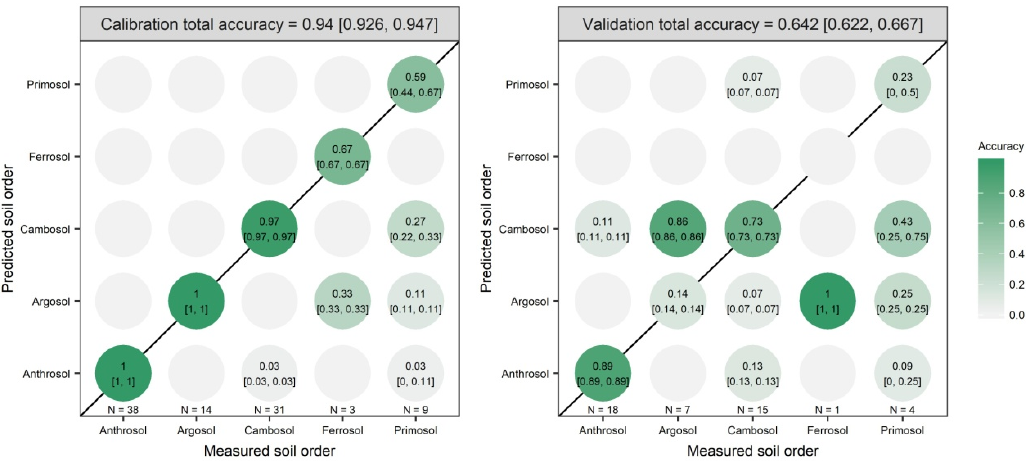
Figure 5. Confusion matrix of soil classification based on vis–NIR spectra. Inside the square brackets are lower and upper limits of the 90% confidence intervals. Outside are mean values. N represents the number of samples in each soil order allocated by model.